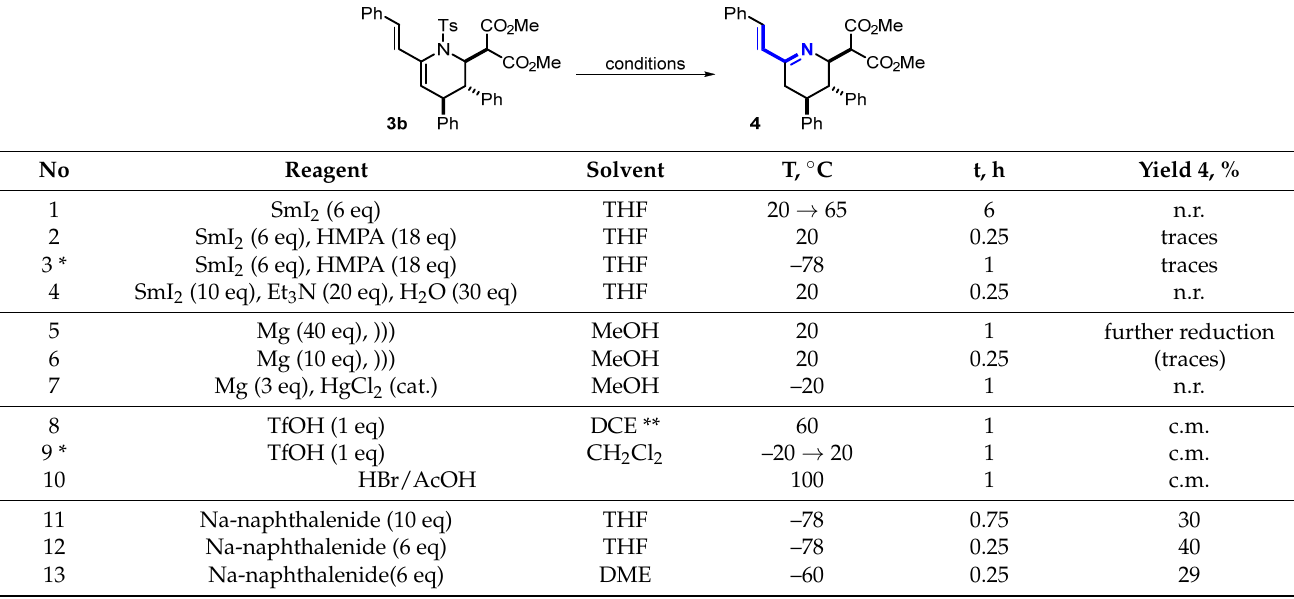
Table 3. The optimization of reaction conditions for detosylation of vinyltetrahydropyridine 3b .